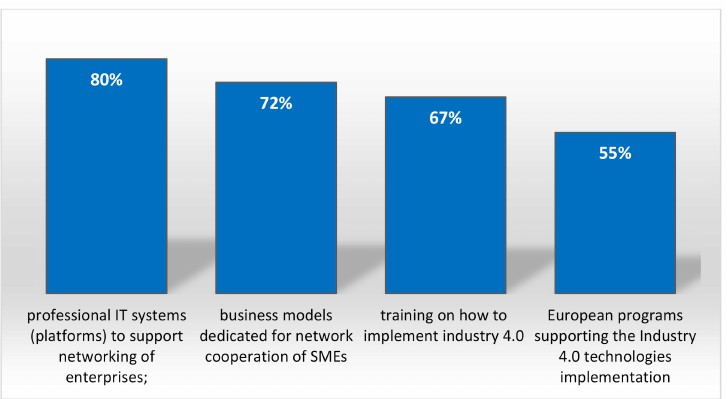
Figure 3. Expectations of SMEs that can support the implementation of the Industry 4.0 concept. Source: own elaboration.